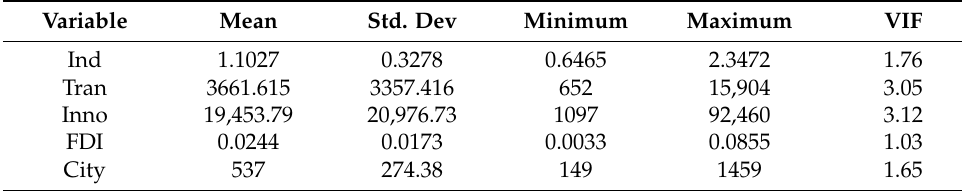
Table 4. Descriptive statistics of the explanatory